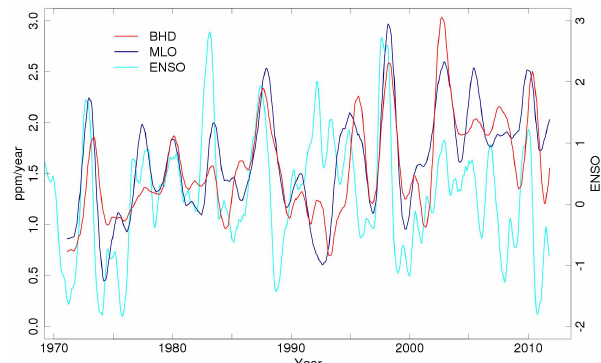
Fig. 8. Monthly mean CO 2 differences between Baring Head and South Pole. Months during the peak (April–June, green) and trough (November–January, purple) of the modeled influence from South- ern Ocean fluxes (Fig. 6) are highlighted and fit with trend lines. The points prior to December 1972 are from the Makara site.